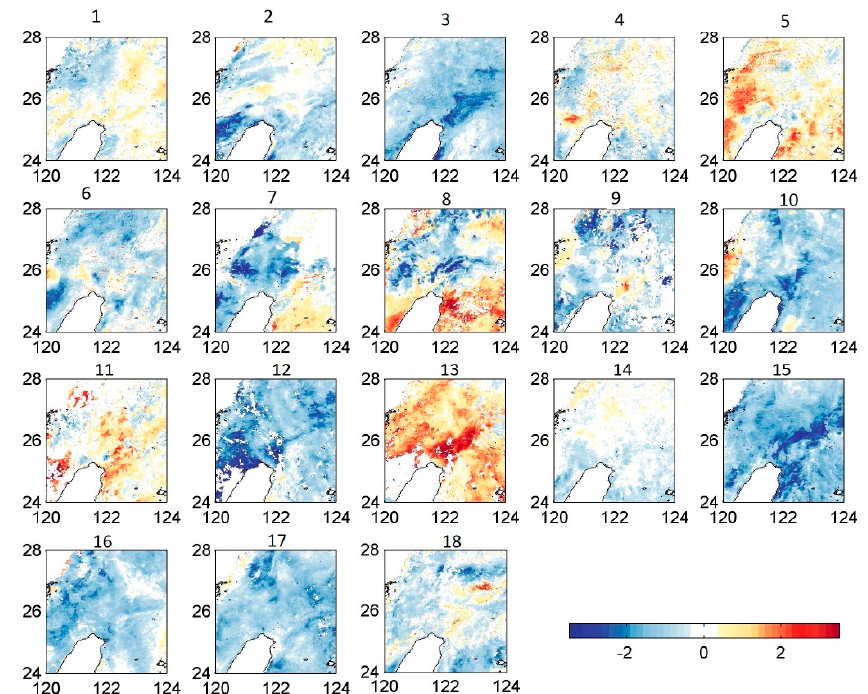
Figure 4. Di ff erence between poststorm and prestorm sea surface temperatures ( ◦ C, one-week composite Remote Sens. 2020 , 12 , x FOR PEER REVIEW images) for the 18 typhoons shown in Figure 2. Figure 4. Difference between poststorm and prestorm sea surface temperatures (°C, one-week composite images) for the 18 typhoons shown in Figure 2.